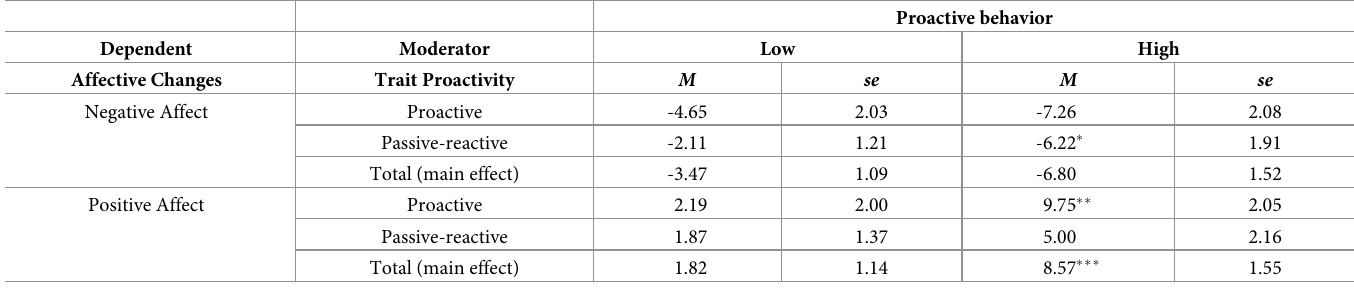
Table 3. Main effects and trait-proactivity � proactive behavior interactions on changes in affect from before (T2) to after (T3) the proactive